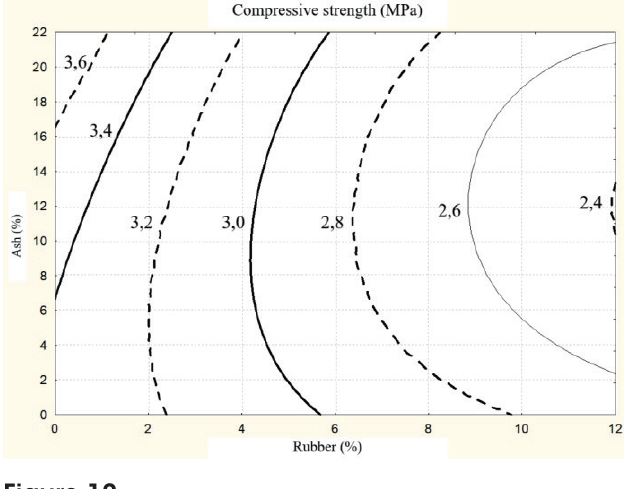
Figure 12 Contour plot on compressive strength in rubber and fly ash factor